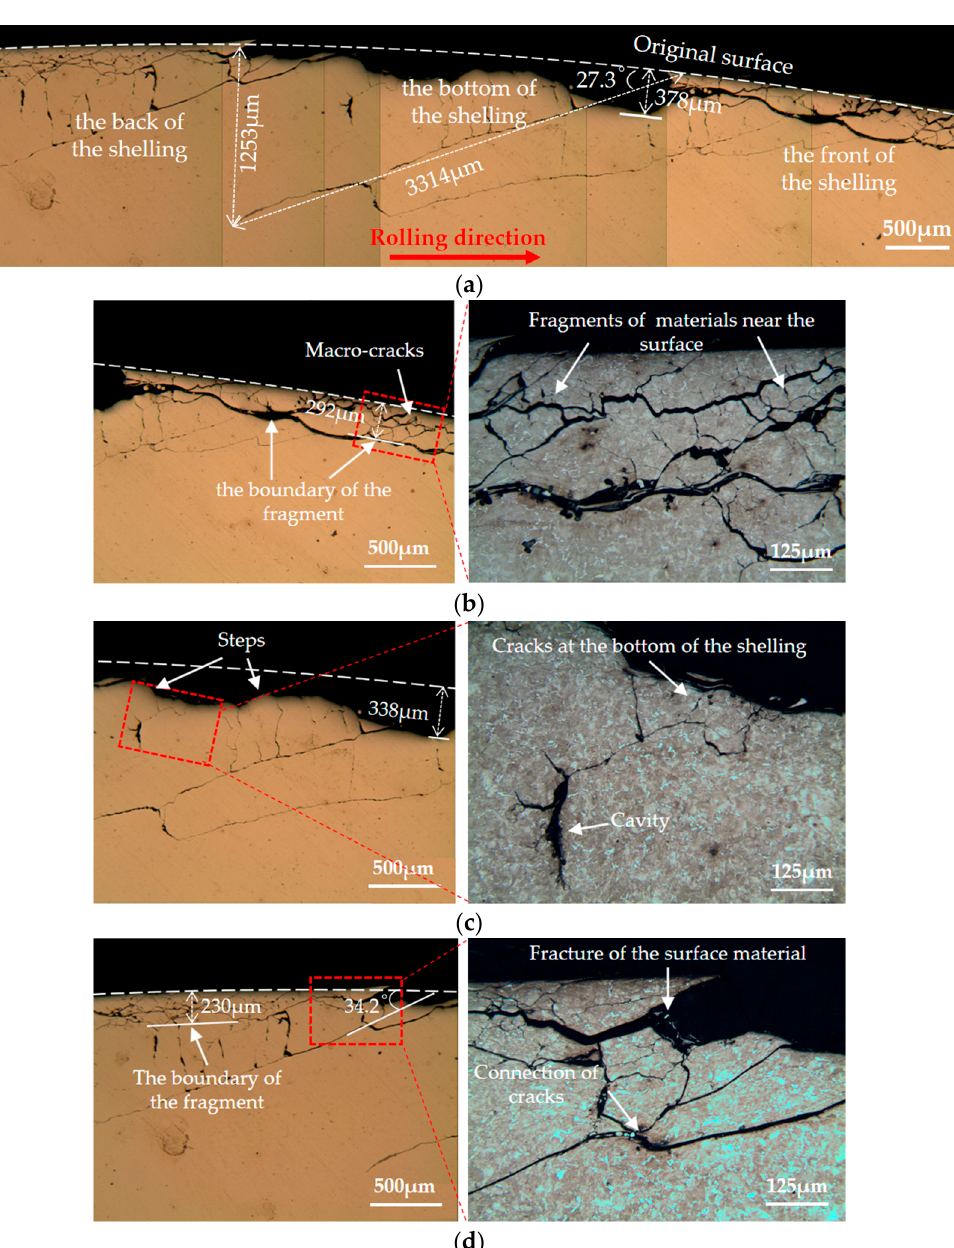
Figure 7. Subsurface damage around the shelling on wheel 1 (standard wheel): ( a ) the overall view; ( b ) the front, ( c ) the bottom and ( d ) the back of the shelling.